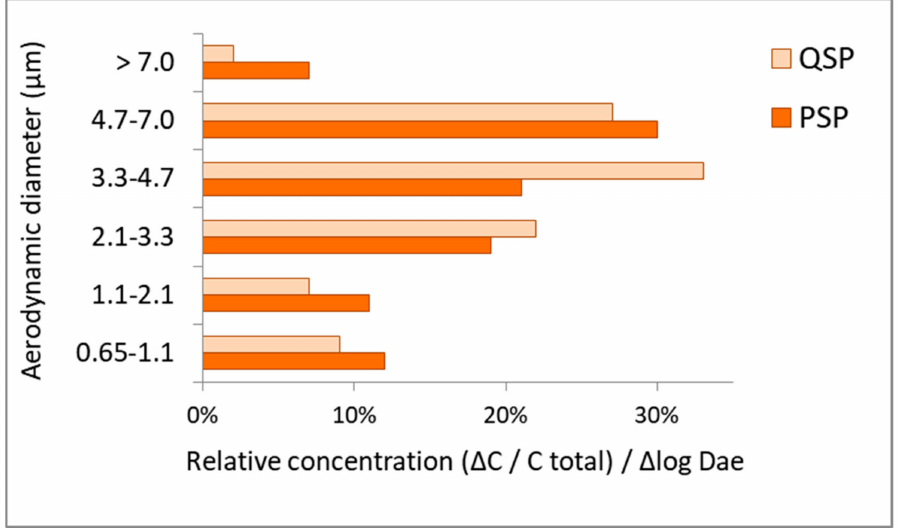
Figure 2. PSD of fungal aerosol in the analyzed WSP. D ae —aerodynamic diameter; ∆